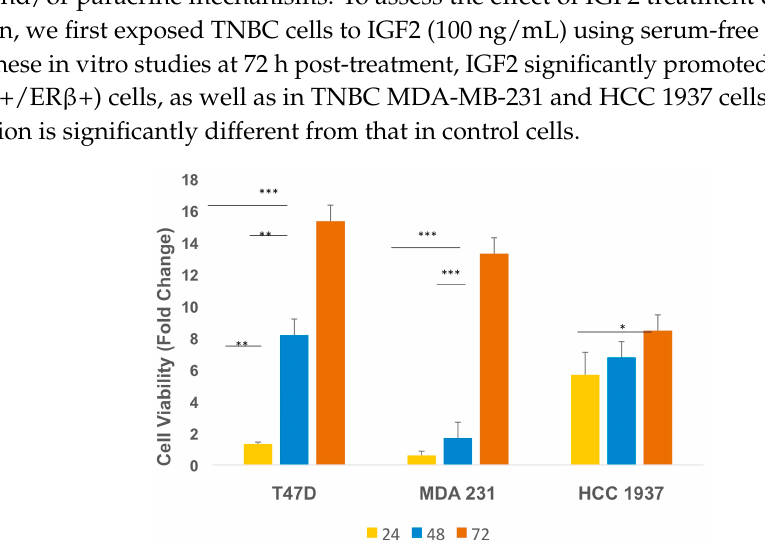
Figure 1. Insulin-like growth factor-2 (IGF2) promotes triple-negative breast cancer (TNBC) cell viability. Initial plating consisted of 1.0 × 10 5 cells per well. Plated cells were cultured in complete media for 48 h followed by incubation in serum- and phenol red-free medium for 24 h. Cultures were then maintained in IGF2 (100 ng/mL)-containing media for 24, 48 and 72 h. IGF2 culture media was refreshed every 24 h. Viable cells were counted using trypan blue exclusion. Data represents at least three